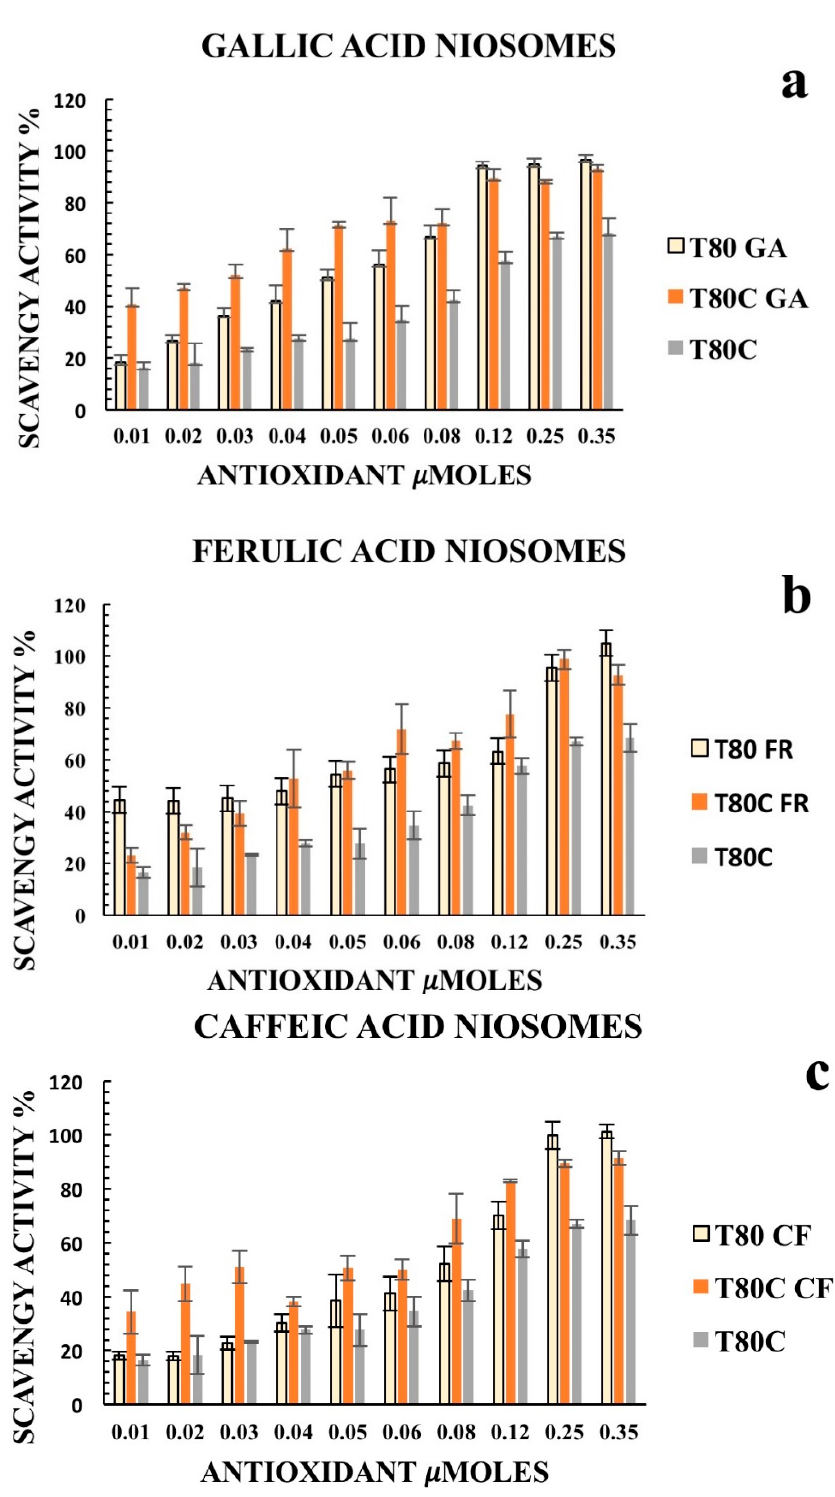
Figure 4. Antioxidant activity of empty (yellow) and CUR-loaded (orange) T80-GA ( a ), T80-FR ( b ), and T80-CF( c ) against DPPH • expressed as a percentage of radical scavenging activity versus antioxidant µmoles grafted on the niosomes’ surfaces. Data represent the mean ± S.D. of three independent experiments performed with triplicate measurements. Table 3. SC50 values of antioxidant-functionalized niosomes in DPPH and ABTS scavenging assay. Results represent the mean ± S.D. of three independent experiments performed with triplicate meas-